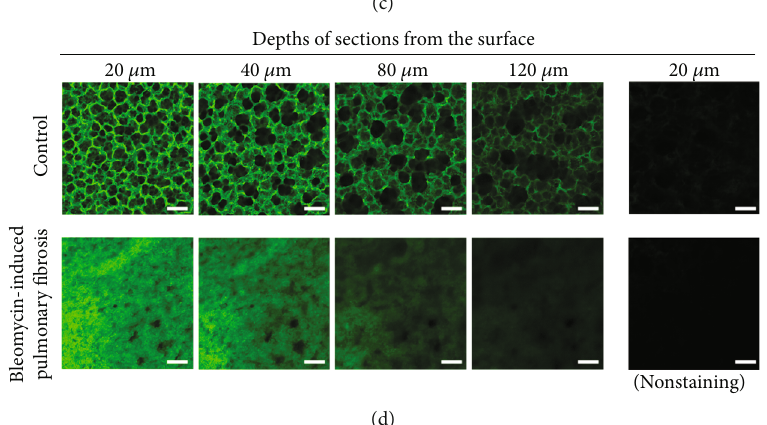
Figure 4: Fluorescence labeling of fi brotic lungs using fl uorescence-conjugated tomato lectin. (a) Serial lung sections were stained using DyLight 488-conjugated tomato lectin and Masson ’ s trichrome technique. (b – d) DyLight 488-conjugated tomato lectin (2.5mg/kg) was intravenously administered to mice with bleomycin-induced pulmonary fi brosis. After Clear T2 tissue-clearing treatment, the lungs were observed using confocal microscopy. (b) Three-dimensional images were reconstructed from single-plane images. Each 5 μ m stack is 20 – 120 μ m below the lung surface. (c) The image of cross-sections indicated by the red lines in (b). (d) Single-plane images at the indicated depth ( μ m) from the lung surface. Green fl uorescence indicates the localization of tomato lectin. Scale bar is 100 μ